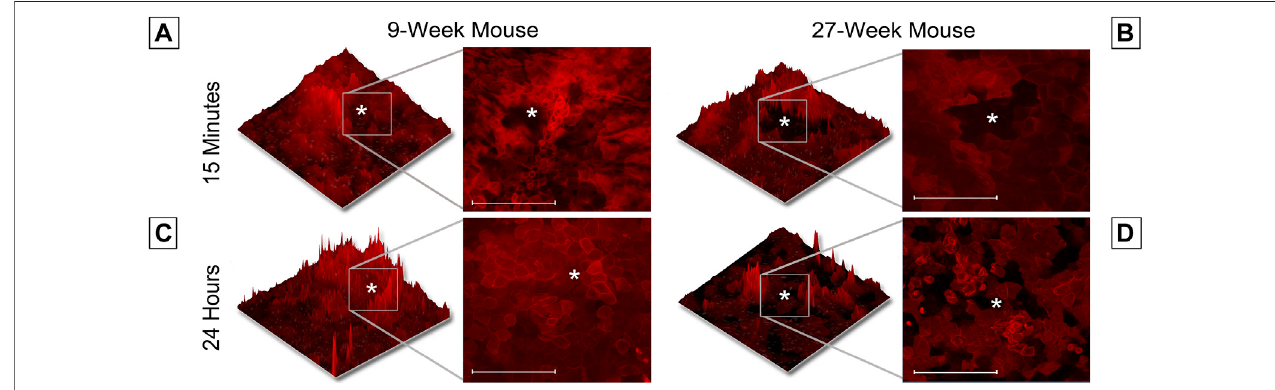
FIGURE4| Woundhealingoccursmorerapidlyin9-weekthan27-weekmice.EnucleatedglobeswerestainedwithCellMaskDeepRed(red)andimagedusingthe Zeiss LSM 880 confocal microscope both before and after healing for 24 h in growth media. Images were taken of corneal wounds 15 min or 24 h after injury in both 9- week (A,C) and27-week (B,D) mice.Inallimages, thewoundismarkedwithawhiteasterisk.Twelve opticalsections ofonemicroneach weretakenforeverycondition and Zen software was used to make a 2.5D topographical map of the wounds in the corneas. After 24 h, wounds in 9-week mice had fully closed. Wounds in 27- week mice remained open. Wound depth (Two-tailed Student ’ s t-test, p = 0.999) and diameter (Two-tailed Student ’ s t-test, p = 0.999) were consistent between samples. The data represent three eyes per condition, with each eye from one mouse. Scale bar represents 20